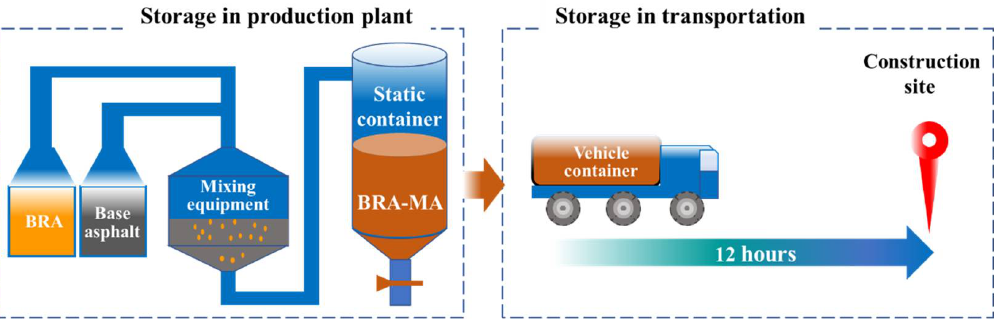
Figure 4. Storage process of BRA-MA in a production plant and during transportation.